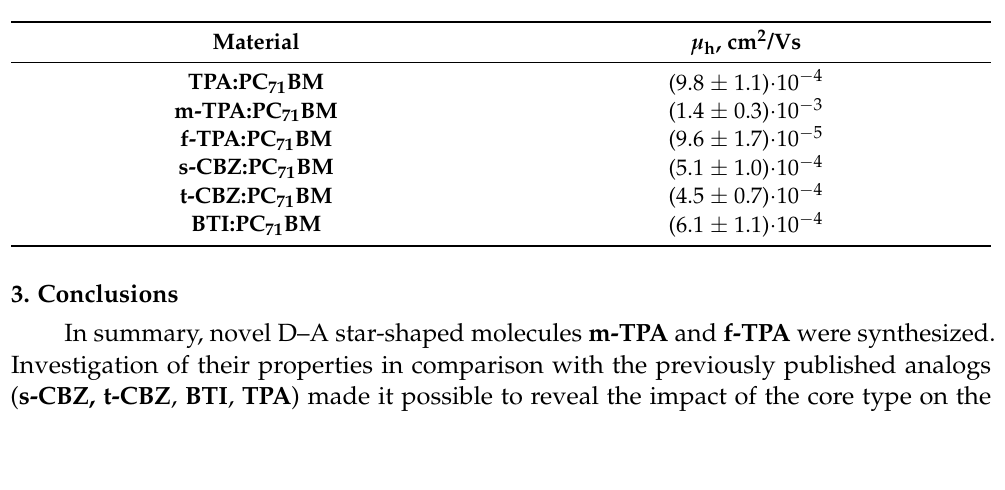
Table 7. Hole mobilities in the blended